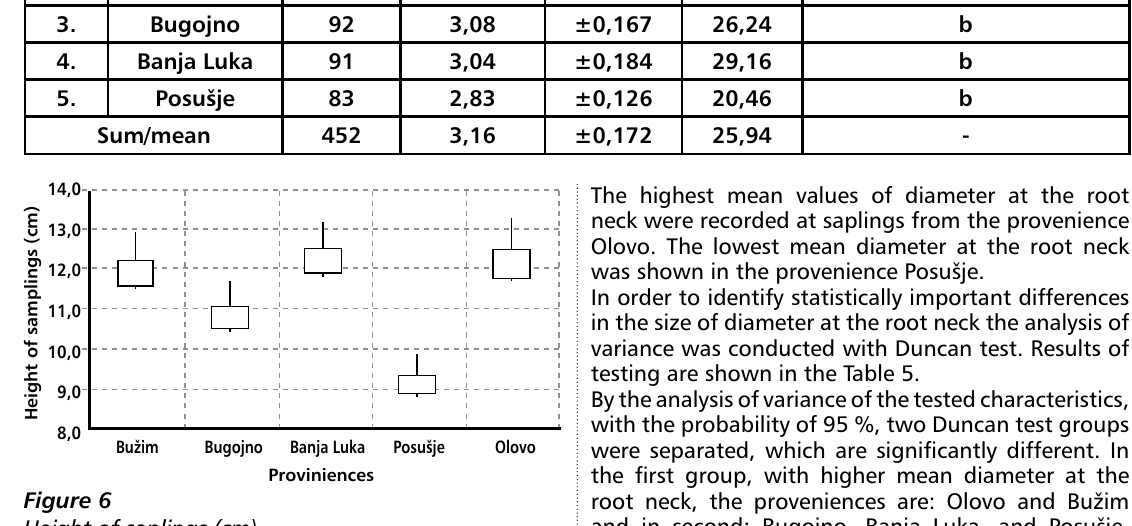
Height of saplings